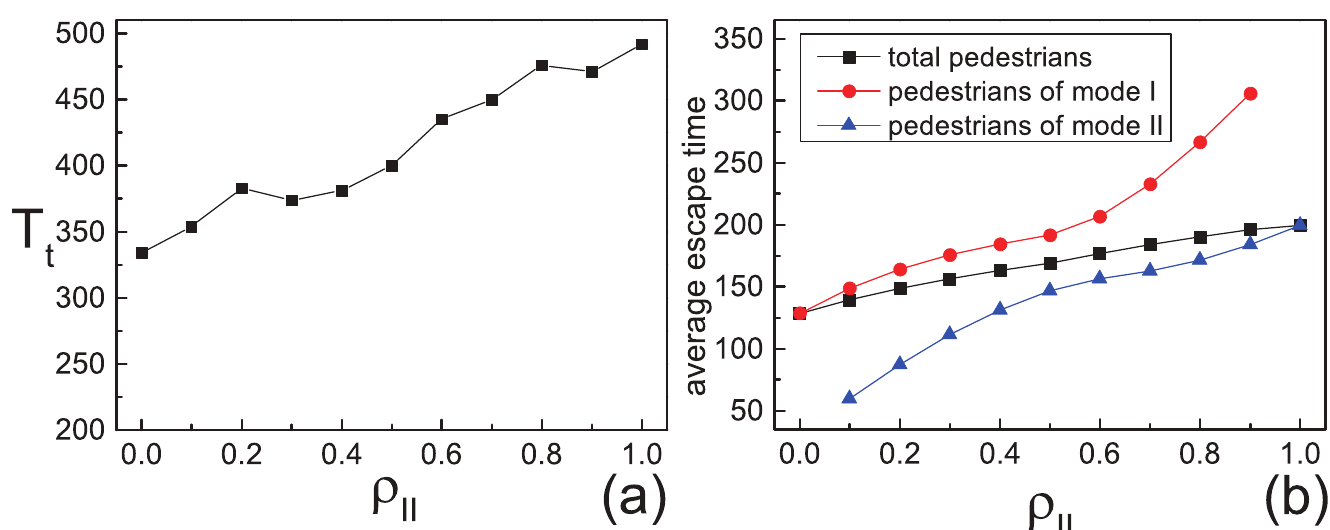
Fig 2. The escape time of fixed motion mode. All the data points above are obtained by averaging over 500 different realizations. (a)The escape time T t that all the pedestrians escape from the room. (b)Average escape time as functions of ρ II .